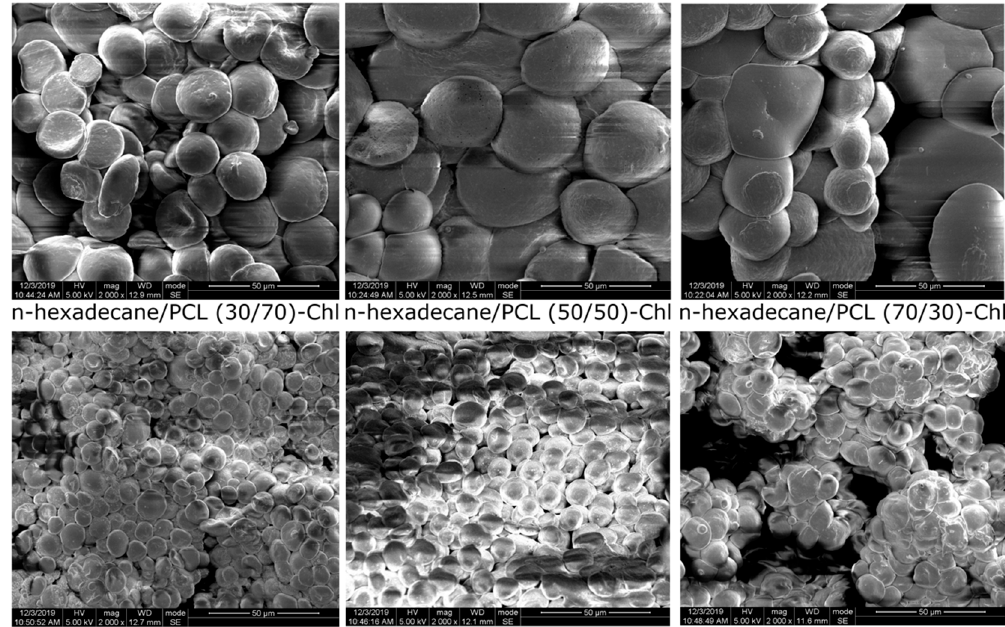
Figure 7. SEM micrographs of n -hexadecane / PCL microparticles after thermal treatment.